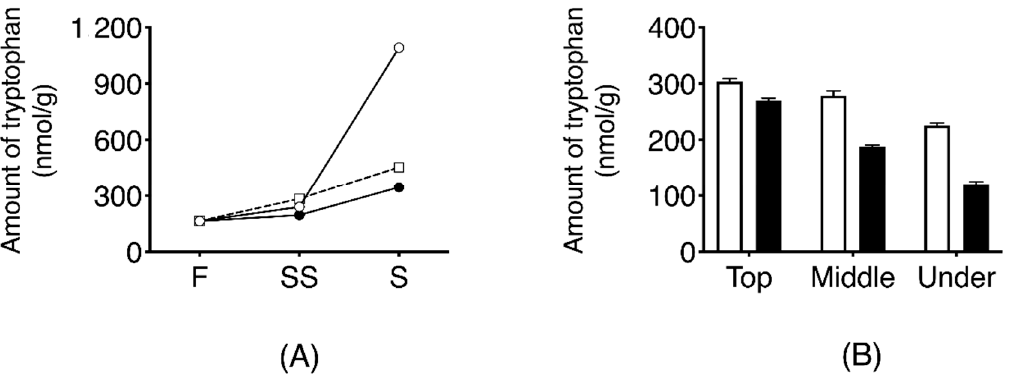
Figure 6. Temporal changes in the quantity of tryptophan obtained from daikon during the dehydrating and salt-aging process ( A ). Effect of dehydration treatment on tryptophan production. F indicates the value derived from fresh daikon. SS indicates the amount of tryptophan obtained from dehydrated daikon after two days of salting. S indicates the amount of tryptophan collected from the dehydrated daikon after one week of salting. Symbols: ○ , dehydrated by sun-drying with leaves (DR); □ , dehydrated by sun-drying without leaves (nDR); ● , dehydrated by salt-pressing (SR). The error bar cannot be displayed because the standard deviation is small. ( B ). Localization of tryptophan in dehydrated daikon with leaves after two days of salting (DR-SS) white bar, inside radish; black bar, outside radish (on the skin).